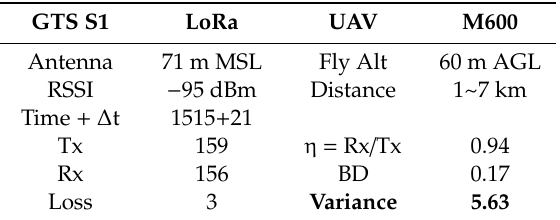
Table 1. Test data at CJCU (S1).